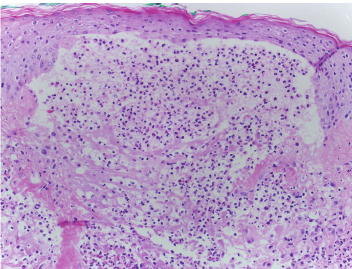
Figure 2: 3mm punch biopsy-upper back skin with focal subepi- dermal vesicles with neutrophilic microabscesses, perivascular and interstitial neutrophilic dermal infiltrate with leukocytoclasis